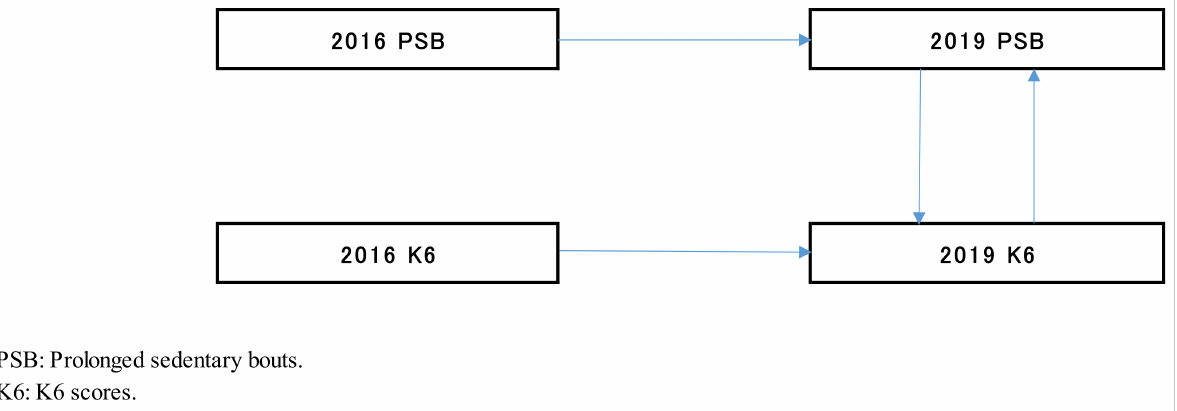
Figure 3. Synchronous effects